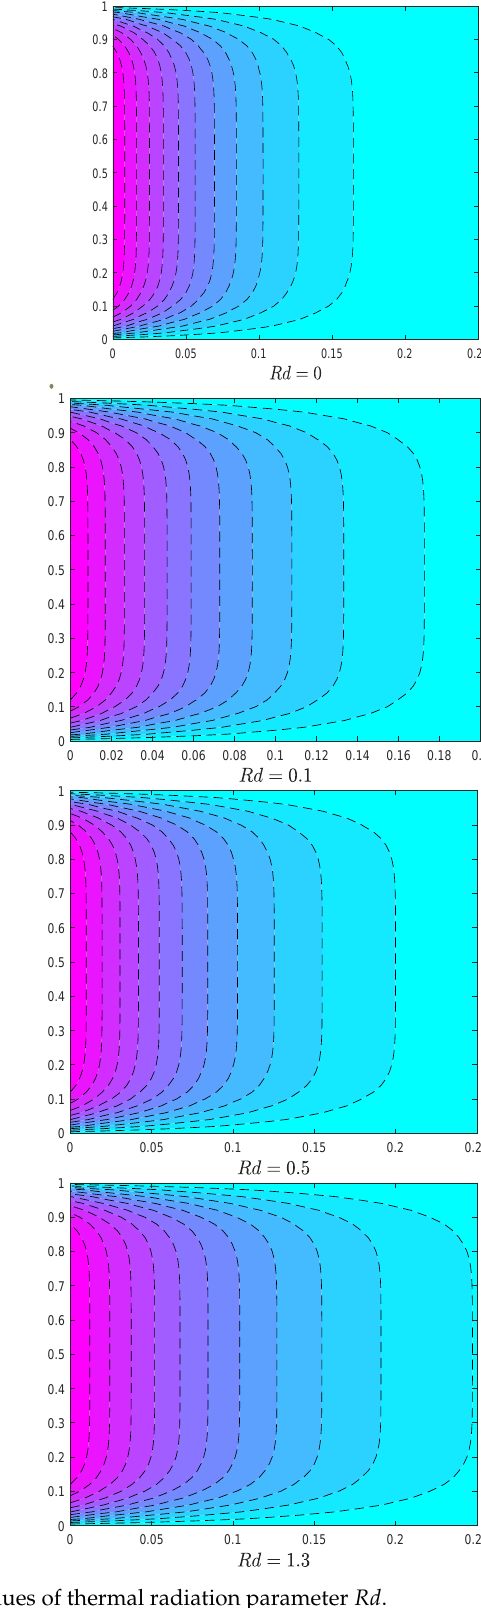
Figure 8. Temperature profile for different values of thermal radiation parameter Rd